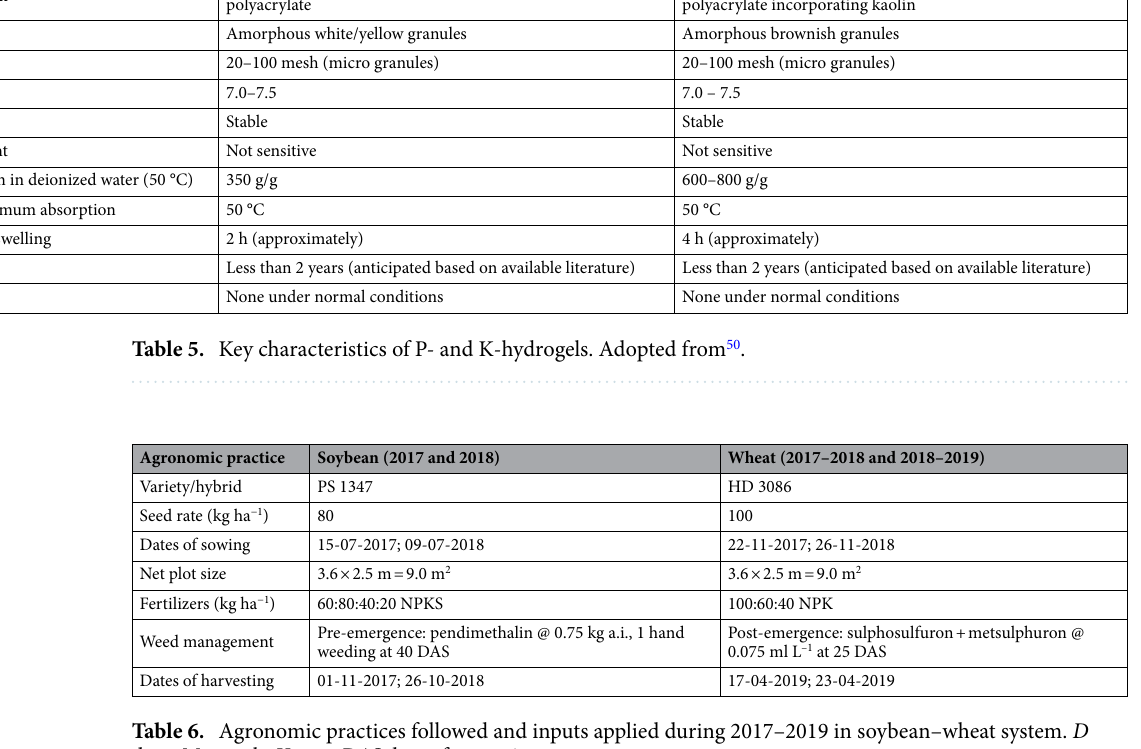
Table 6. Agronomic practices followed and inputs applied during 2017–2019 in soybean–wheat system. D date, M month, Y year, DAS days after